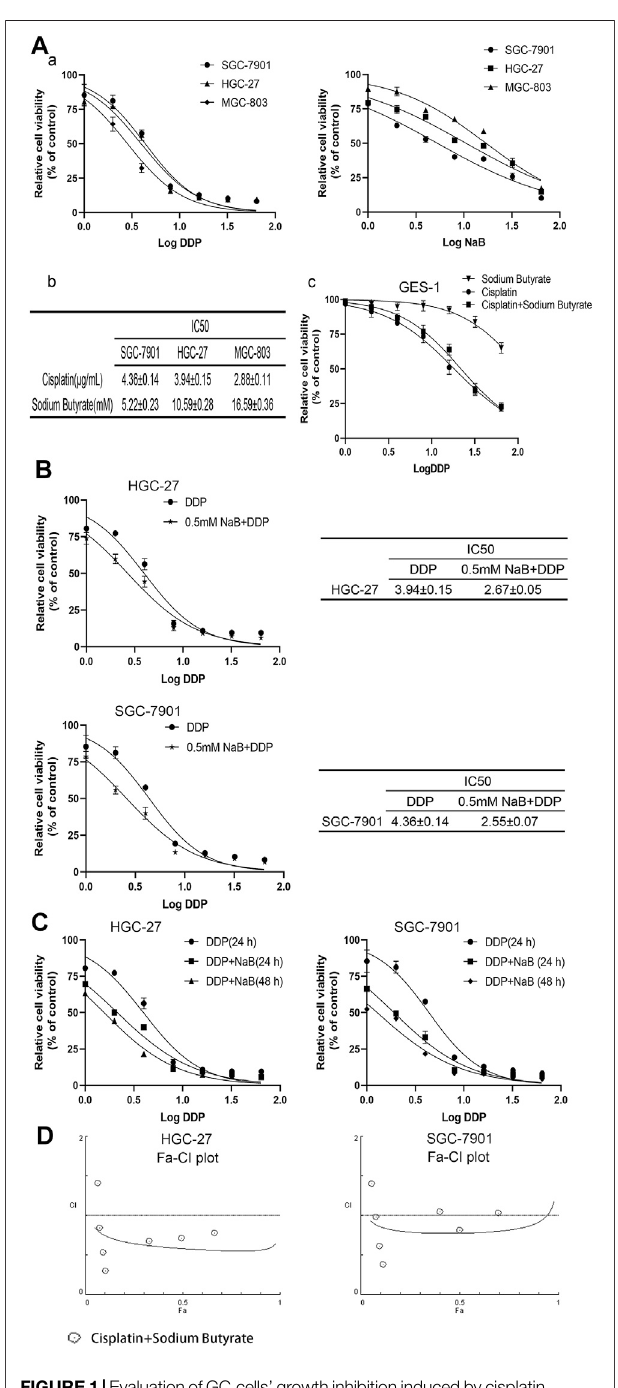
FIGURE 1 | SGC-7901 cells were treated with cisplatin and a combination of cisplatin and sodium butyrate for 24 h or 48 h. (D) CompuSyn software was used to de fi ne the type of drug-combination effect. All the above data are shown as the mean ± SD from an average of three